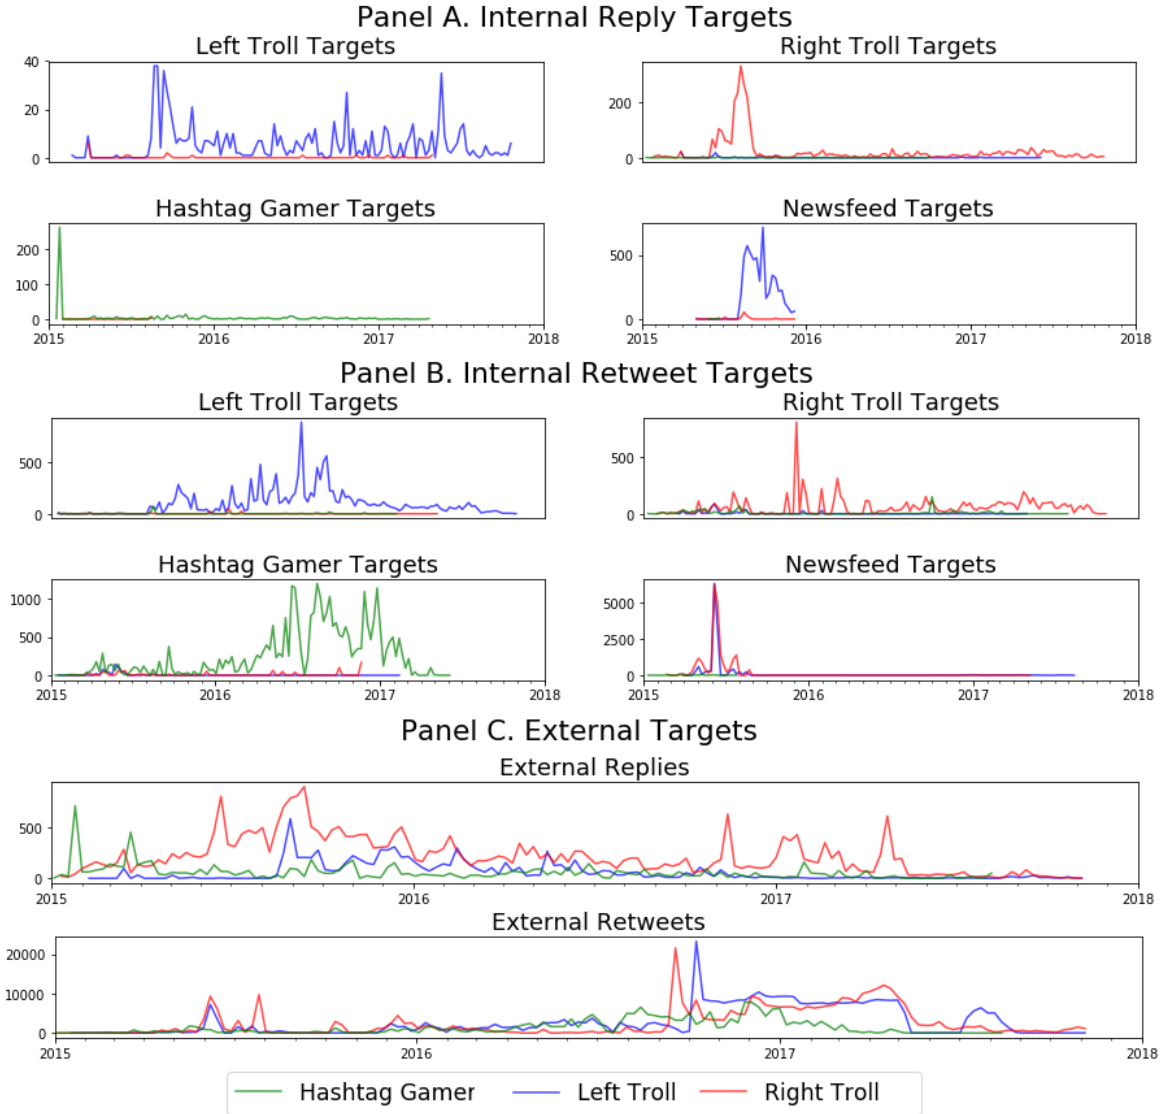
Figure 1. Output within and outside the IRA Network, by Target Type and Origin Type over Time.Note: Each panel presents a timeline of the count of networked tweets originating from the IRA that target accounts of the indicated type. The color of the line indicates the origin account